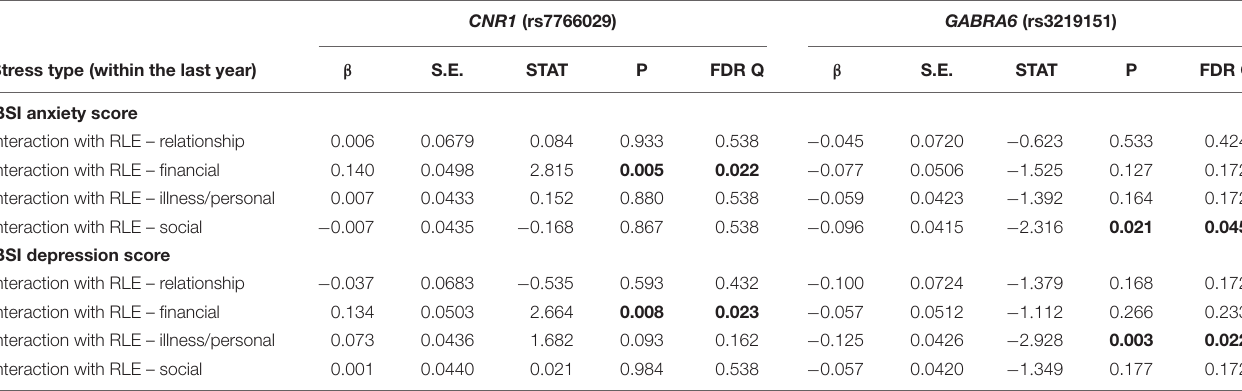
TABLE 3 | Interactions of number of recent negative life events and CNR1 (rs7766029) or GABRA6 (rs3219151) polymorphisms on BSI anxiety and BSI depression scores as the outcome in the combined Budapest + Manchester